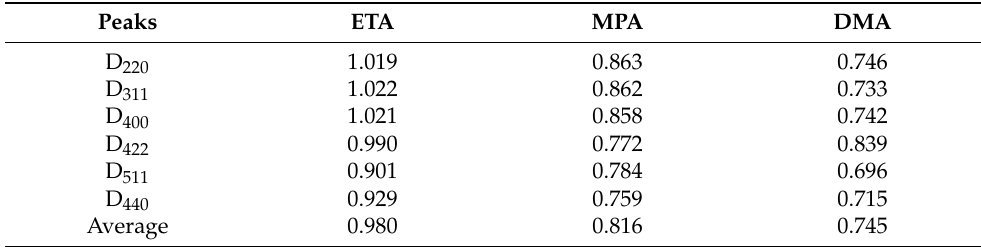
Table 3. Crystallite size using three advanced amines calculated by JADE9 software 9 (Materials Data, Inc., Livermore, CA, USA) and Sherrer’s formula ( µ m). Peaks ETA MPA DMA D 220 1.019 0.863 0.746 D 311 1.022 0.862 0.733